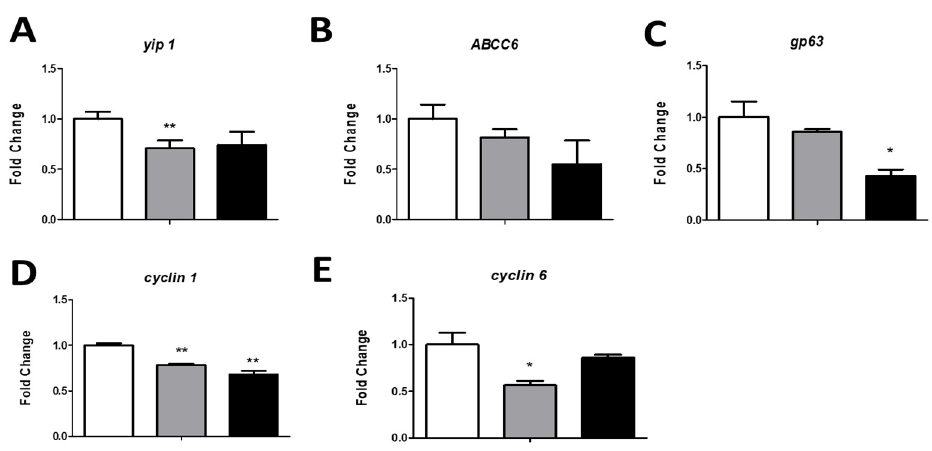
Figure 2. The effect of 19-2.5 and 19-4 LF on L. major amastigotes gene expression levels. The graphs show the expression levels of genes related to drug resistance, [ yip 1 ( A ), ABCC6 ( B )], virulence [ gp63 ( C )], and Leishmania proliferation [ cyclin 1 ( D ), and cyclin 6 ( E )] after 24 h of treatment with 19-2.5 (1 µg/mL) and 19-4 LF (1 µg/mL). GAPDH was used as a housekeeping gene to normalize L. major gene expression. The amount of each transcript was expressed by the formula 2 ct (GAPDH) − ct (gene) . Bars represent the mean ± SD from three independent experiments. Significant differences compared to control (untreated cells) were indicated (*, p < 0.05; **, p < 0.01).